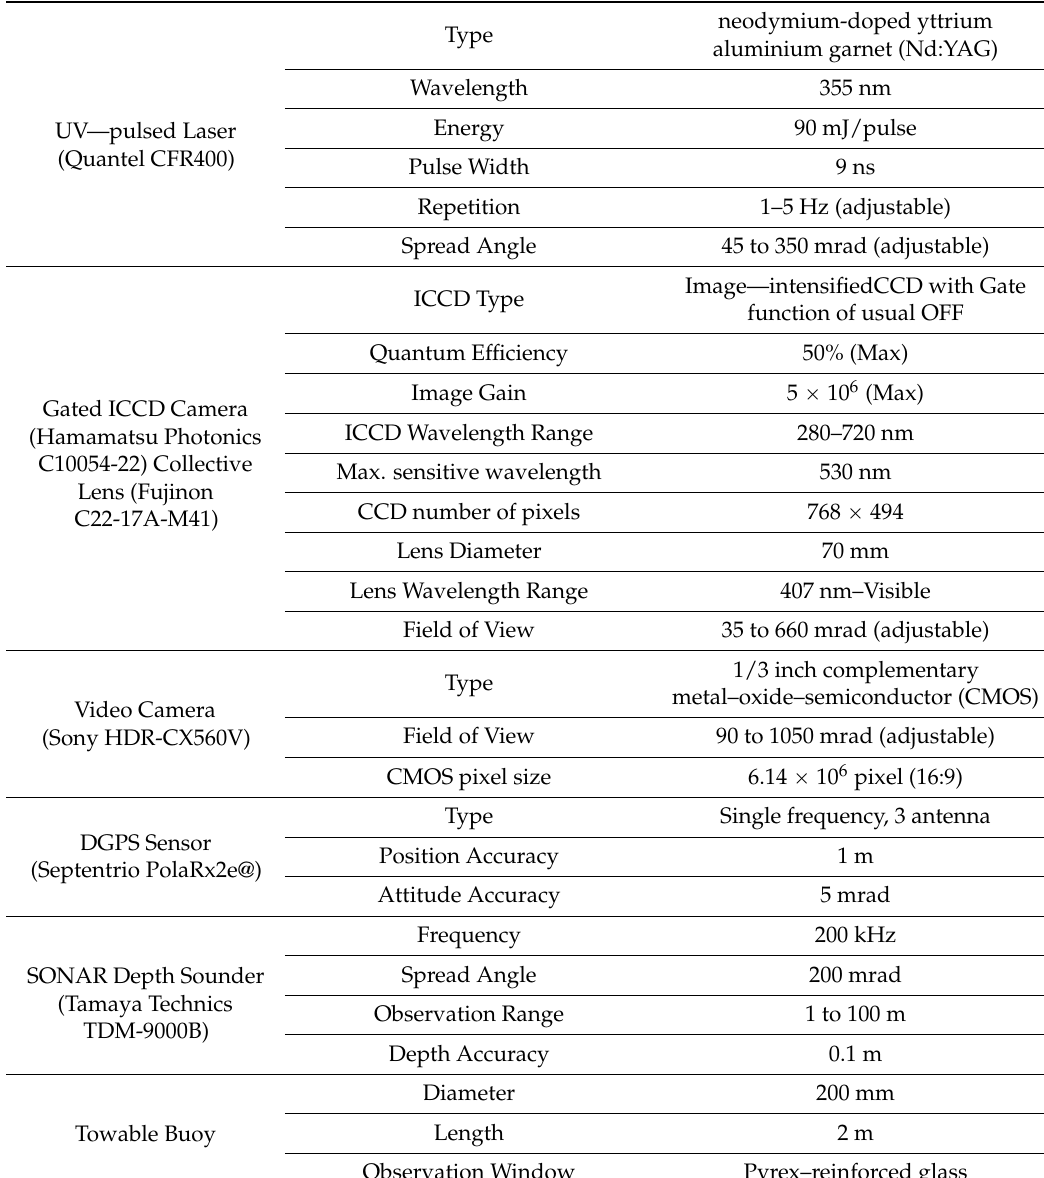
Table 1. Specifications of the fluorescence imaging LIDAR